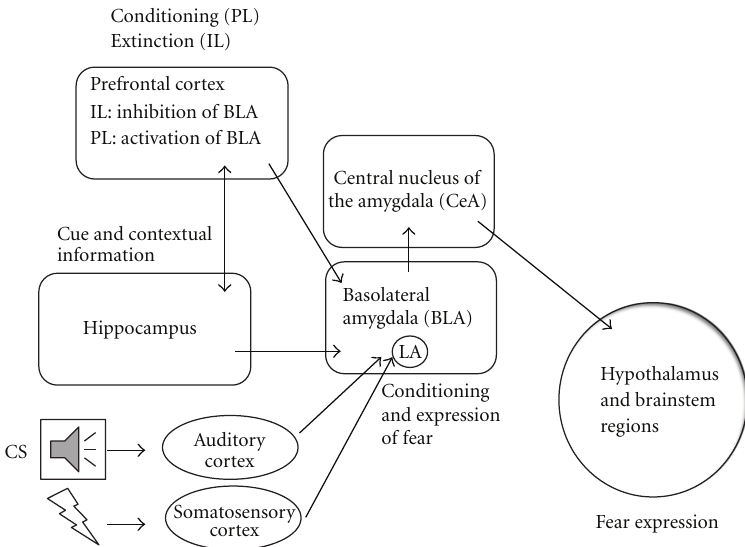
F 2: Simpli�ed scheme of the neurocircuit mediating fear conditioning and extinction. PL: prelimbic cortex� IL: infralimbic cortex� LA: lateral amygdala.